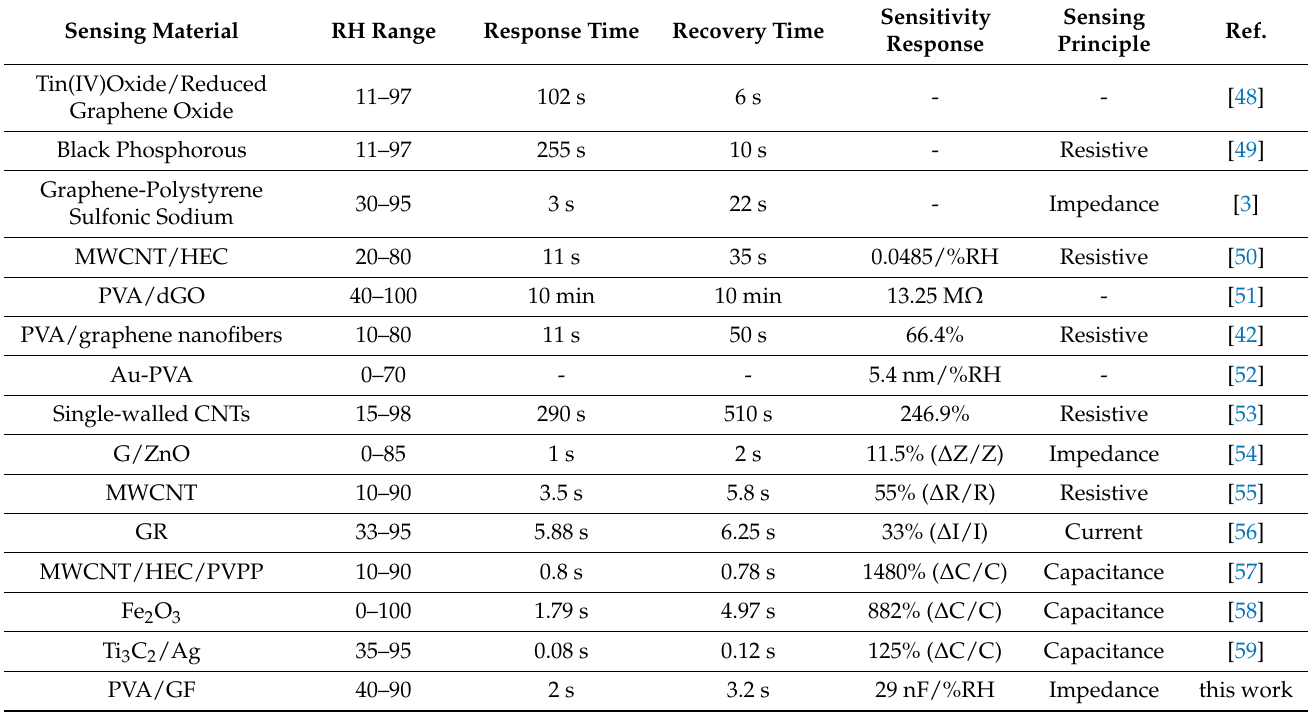
Table 1. Comparison of the response and recovery times with different humidity sensing materials